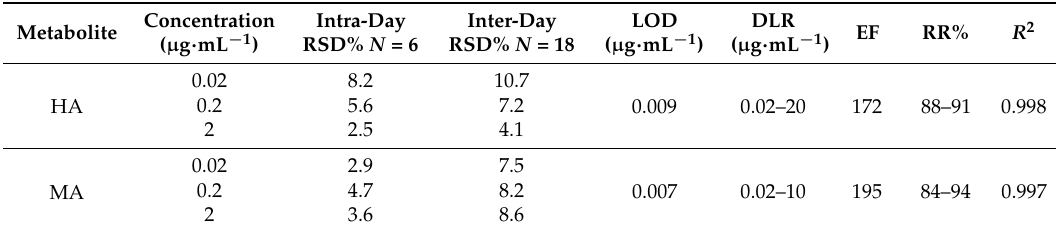
Table 2. Analytical performance of the proposed HF-LPME–HPLC method for extraction of hippuric acid and mandelic acid in